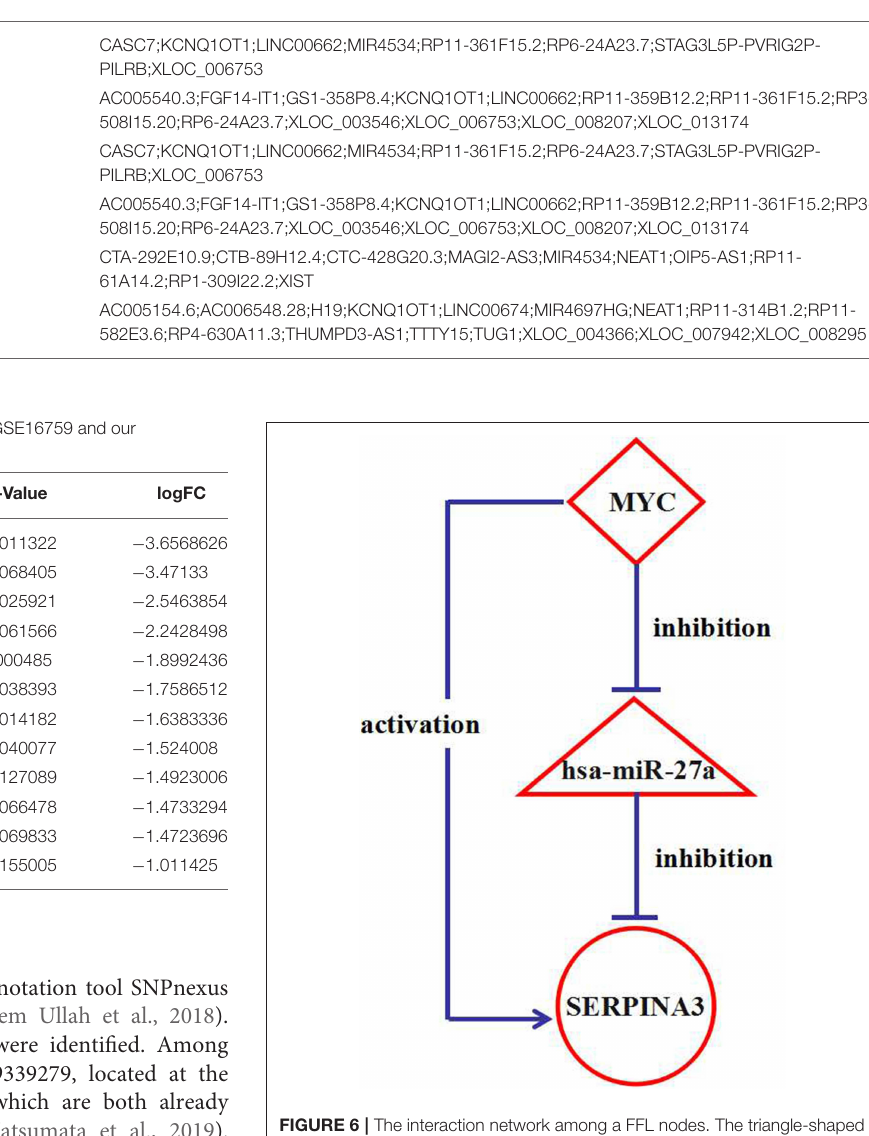
FIGURE 6 | The interaction network among a FFL nodes. The triangle-shaped node represents miRNAs, ellipse-shaped node represents genes, and diamond-shaped node represents transcription factors